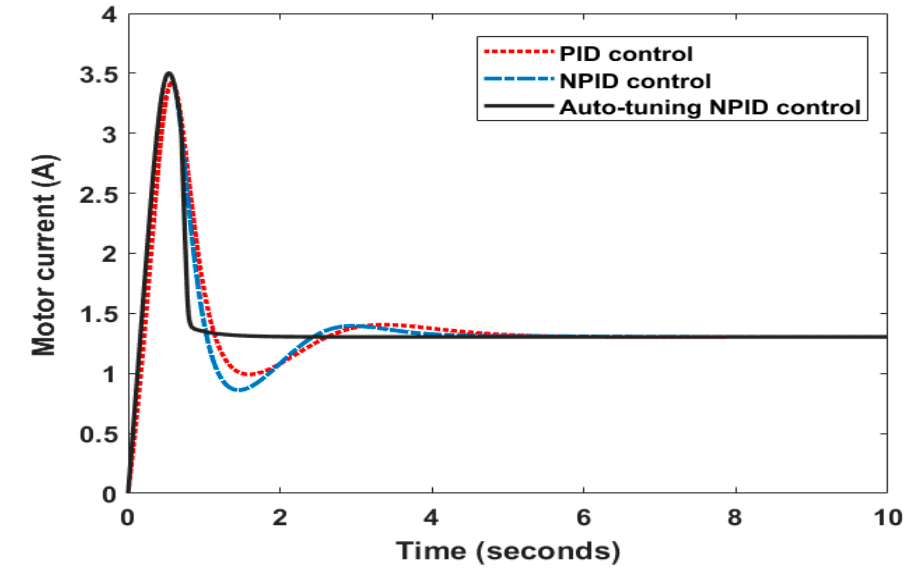
Figure 6. The corresponding rotor current of the motor through a fixed speed reference.